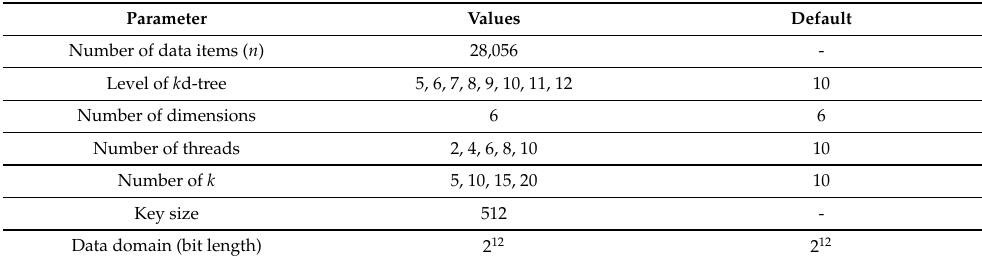
Figure 14. Processing time with a varying number of k in 10 thread. Table 4. Parameters for performance evaluation for real dataset.